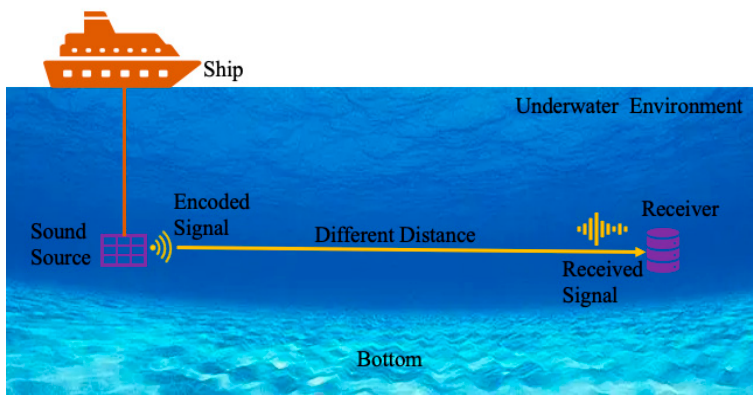
Figure 4. The fl ow chart of the experiment. Figure 4. The flow chart of the